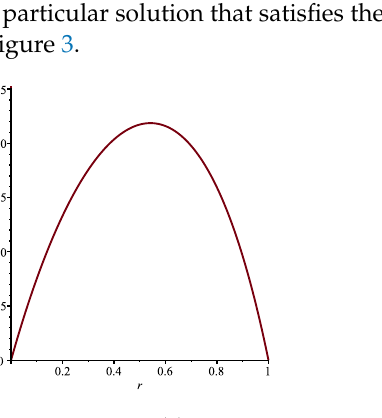
Figure 3. Function n ( r ) for 0 ≤ r ≤ 1, when λ = 1, k 1 = 0 and k 2 =